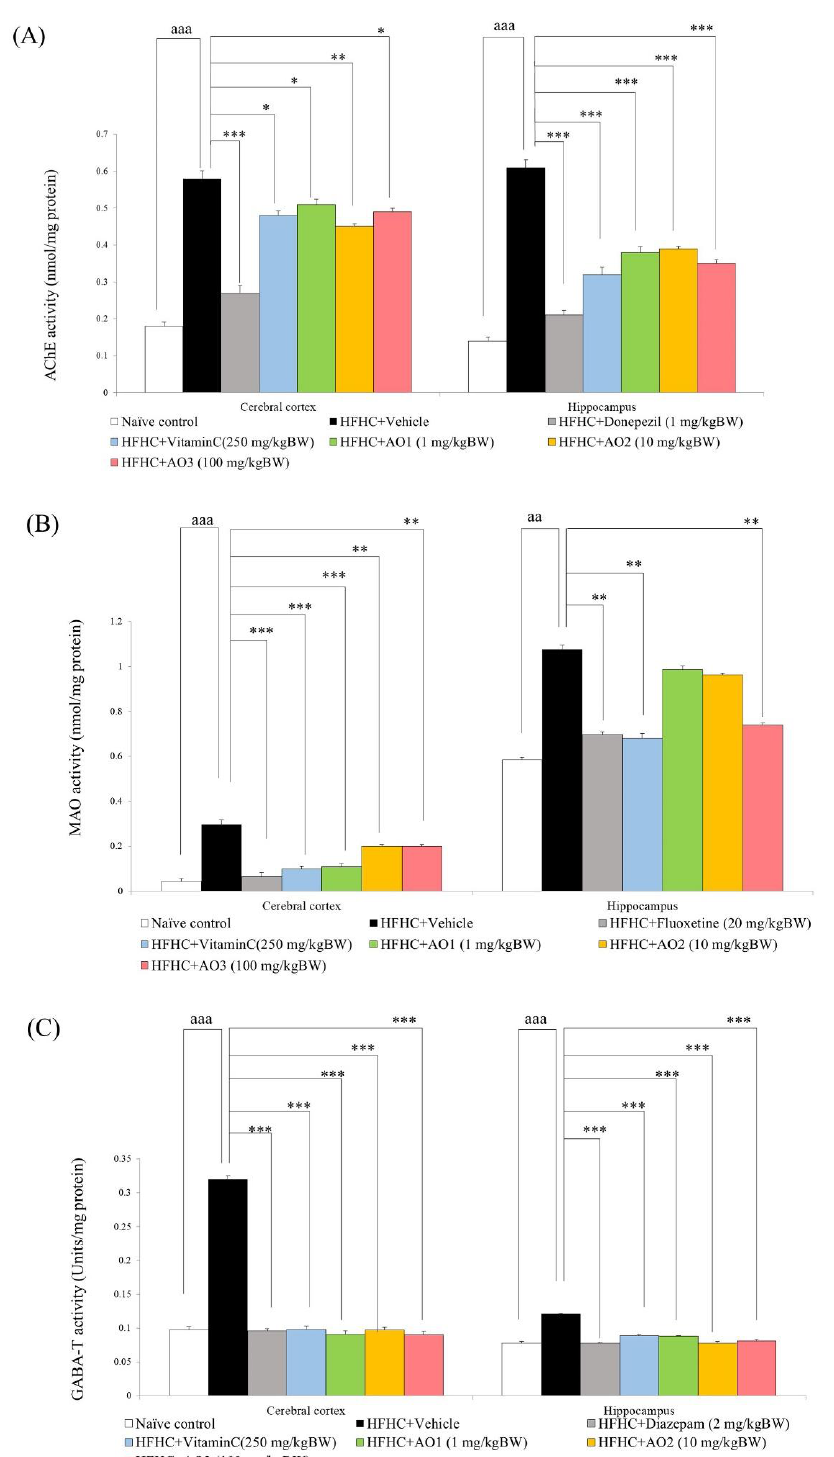
Figure 5. Neurotransmitter changes in cerebral cortex and hippocampus of various treatment groups assessed indirectly via the suppression of inactivation enzymes. ( A ) AChE suppression effect. ( B ) MAO suppression effect. ( C ) GABA-T suppression effect. Data are presented as mean ± SEM ( n = 6/group). aa, aaa p -value < 0.01 and 0.001, respectively; compared to naïve control that received ND and vehicle. *, **, *** p -value < 0.05, 0.01, and 0.001, respectively; compared to metabolic syndrome rats that received HFHC and